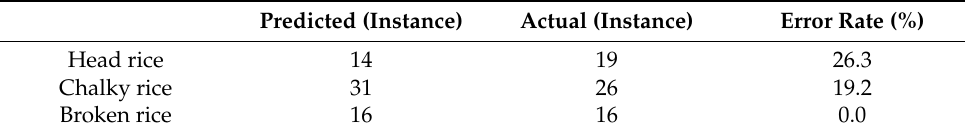
Table 5. Statistic results of rice grain types before improvement.